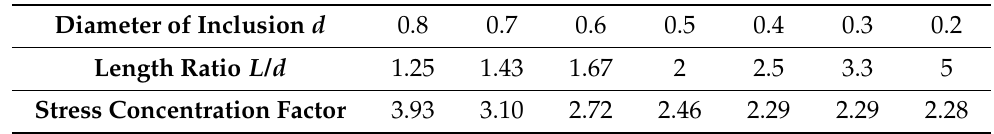
Table 7. Maximum von Mises stress (near equator) with different size of inclusion (30 × 30 × 30 control points) in Figure 23.